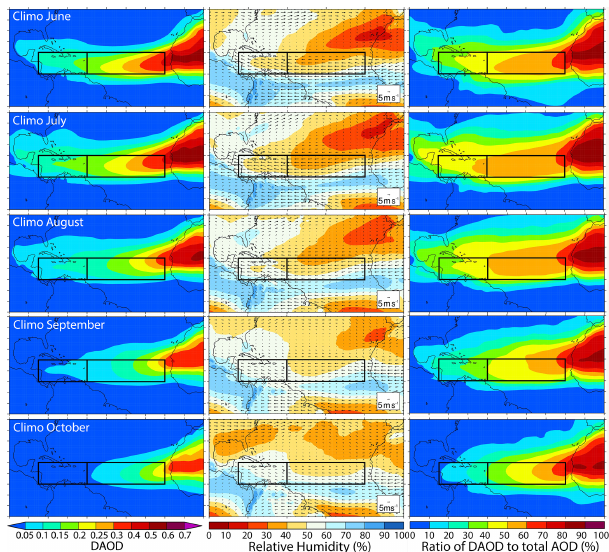
Figure 2. Climatological (2003–2018 average) monthly mean DAOD (left column) and the ratio of DAOD to total AOD (right column) for June–October based on the MRC. The middle column shows the climatological 700hPa RH (color shading) and horizon- tal wind vectors from ERA-Interim. Black boxes denote the MDR, including the Caribbean (left, 10–20 ◦ N, 85–60 ◦ W) and the tropical North Atlantic (right, 10–20 ◦ N, 60–20 ◦ W, denoted “TATL”).